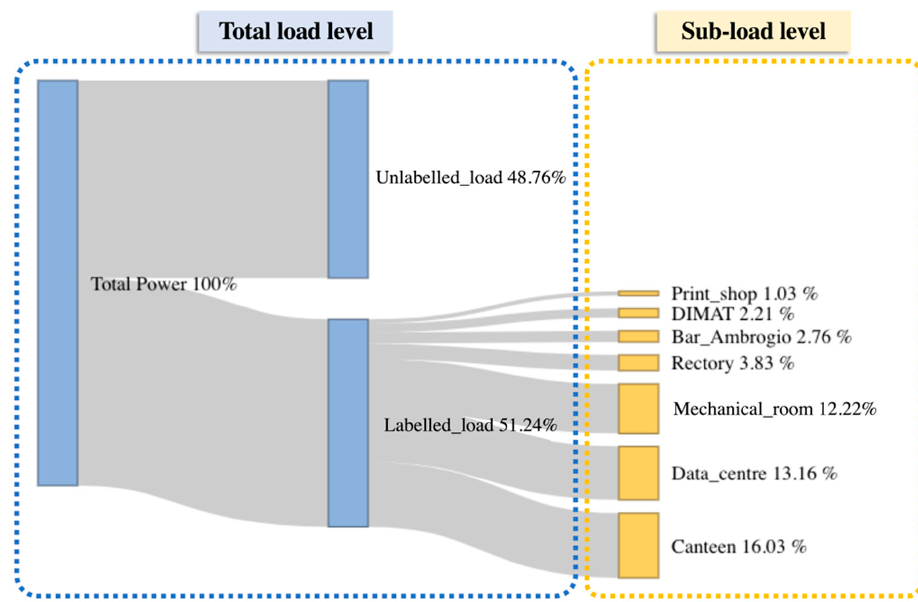
Figure 3. Hierarchical structure of the electrical load database under study.